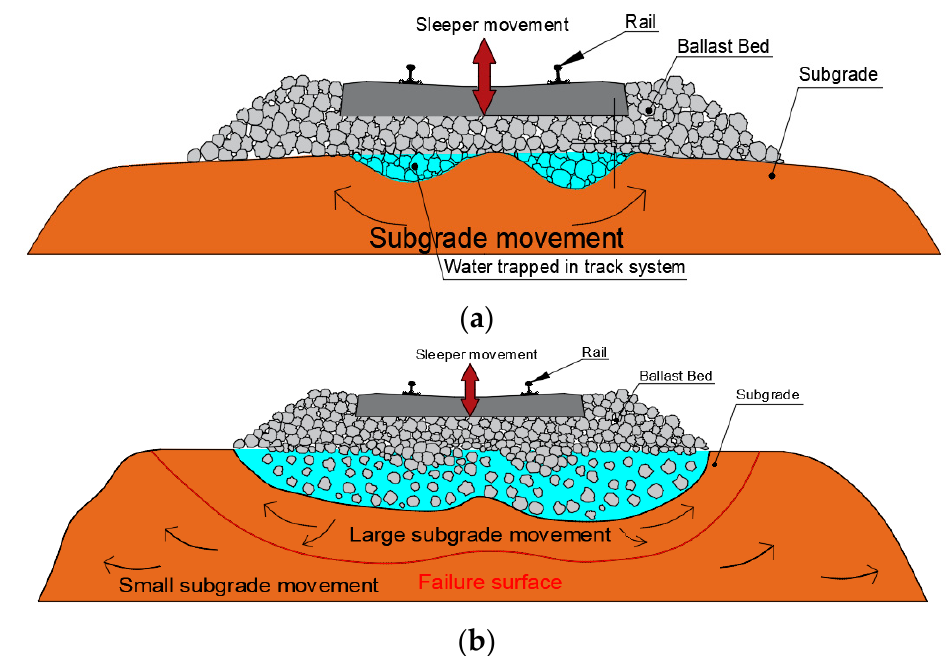
6 of 20 Figure 5. 1:4 interspersed track FEM model. 2.2. Risk Exposures to Flooding and Heavy Rain Conditions 2.2.1. Sleeper Support Conditions The support infrastructures of an interspersed ballasted track are composed of a bal- lasted bed, sub-ballast layer and subgrade. The three layers are assembled of discrete crushed rocks and soil bulk materials. When the infrastructures are exposed to soaking or flood conditions, the subgrade may be softened, moved or washed away under the dy- namic moving train loads [16]. The mechanical properties of the track will deteriorate. The bottom infrastructures under the sleeper deteriorate when subject to moving train load and water ponding conditions. As shown in Figure 6a, the liquefaction of soil bulk near the ballast-subgrade interface occurs under the seismic vibration caused by the dynamic moving train loads. The soil particles start to move towards both sides and vertically un- der the axle loads, and the liquefaction area develops much more broadly, as presented in Figure 6b. The ballast bed layer becomes loose. The crushed ballasted graded gravels